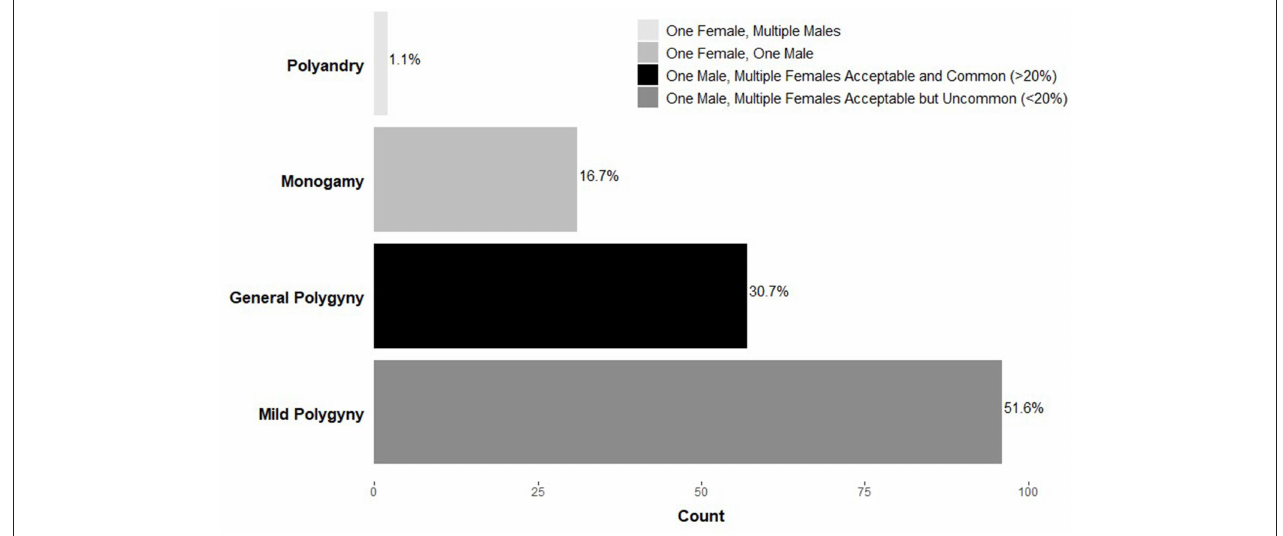
FIGURE 1 | Frequency of marriage systems across societies ( n = 186) in the Standard Cross-Cultural Sample (Murdock and White, 1969). Adapted from Marlowe (2000).